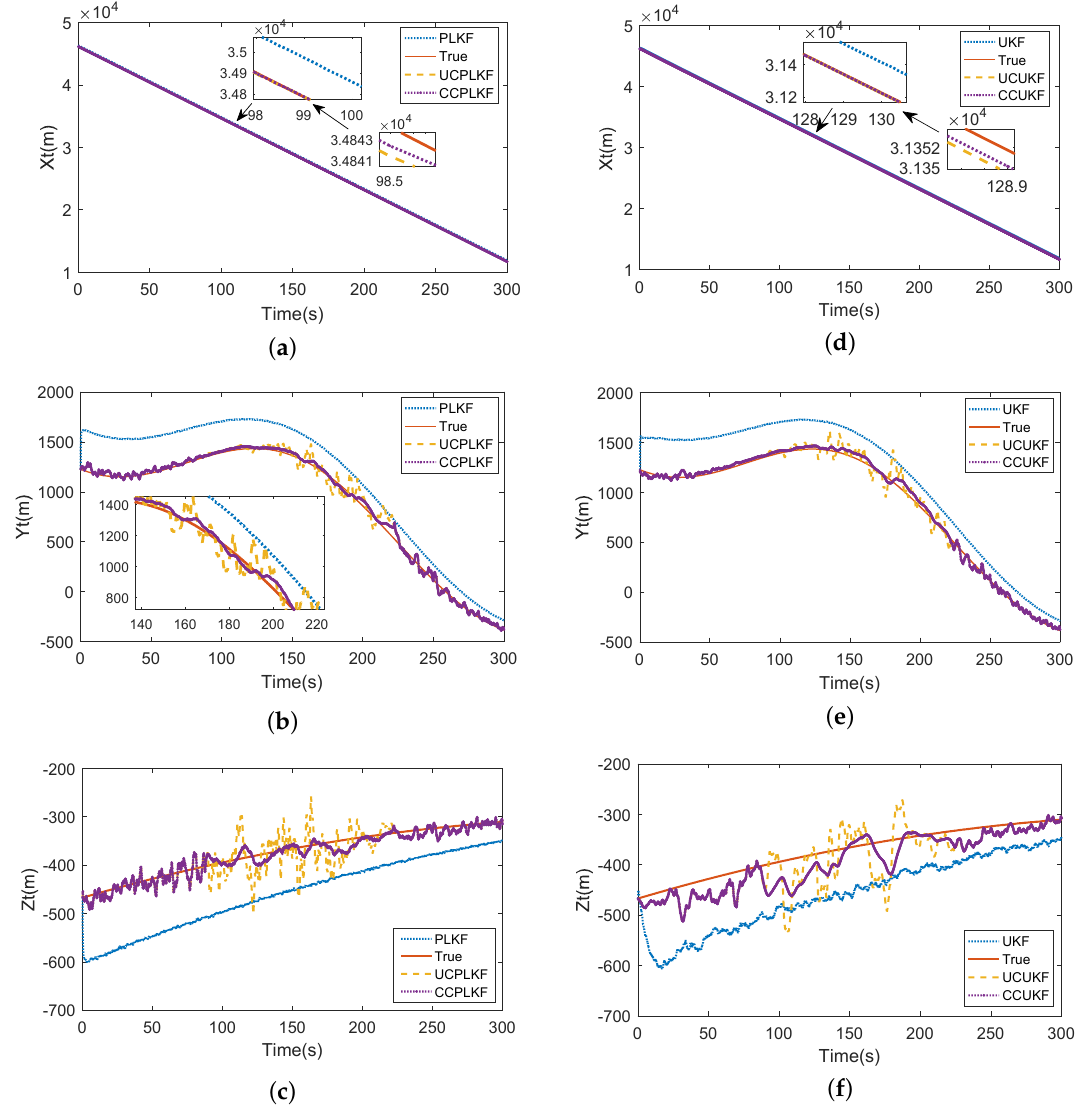
Figure 9. ( a ) Linear estimation of x coordinate of target; ( b ) Linear estimation of y coordinate of target; ( c ) Linear estimation of z coordinate of target; ( d ) Nonlinear estimation of x coordinate of target; ( e ) Nonlinear estimation of y coordinate of target; ( f ) Nonlinear estimation of z coordinate of